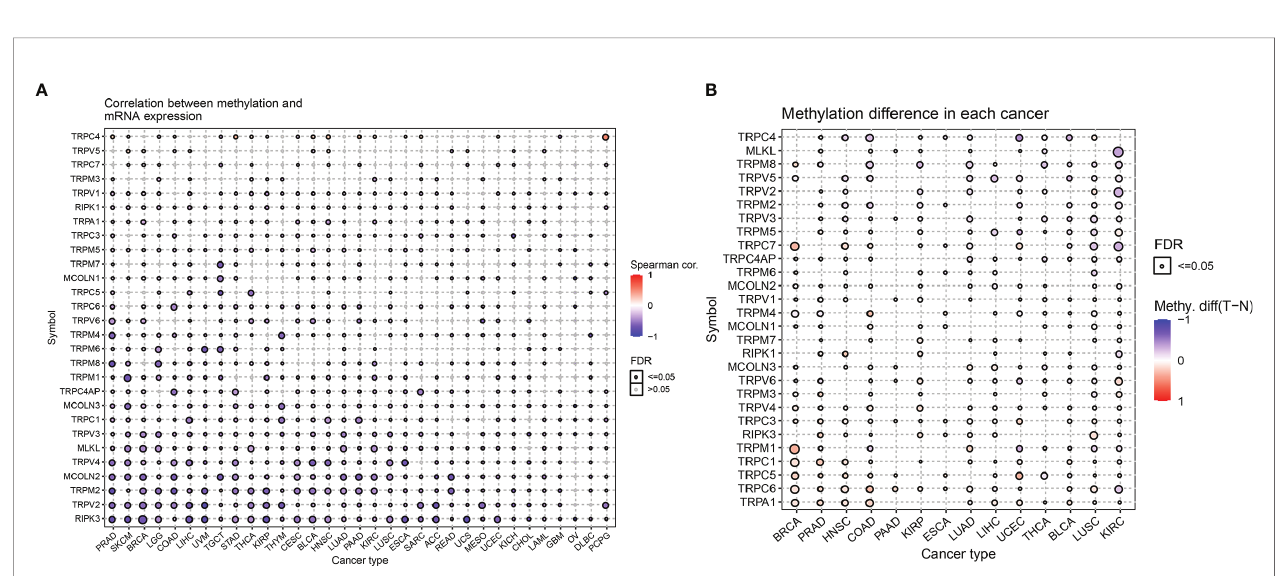
FIGURE 5 | The methylation levels of TRP family genes in pan-cancer. (A) The correlation between methylation and mRNA level of each gene. (B) Summary of the methylation difference between tumour and normal samples of indicated tumour type. The fold-change and FDR are represented with the bubble colour and size, respectively. Red dots represent increased methylation in tumours and blue dots represent decreased methylation in tumours. The darker the colour of the dot, the larger the difference in methylation